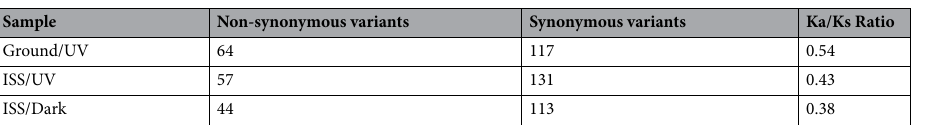
Table 1. Genome-wide Ka/Ks ratios. Ka non-synonymous variant, Ks synonymous variant, ISS international space station, UV ultraviolet light, Ground/UV earth with UV exposure, ISS/UV ISS with UV exposure, ISS/ Dark ISS without UV